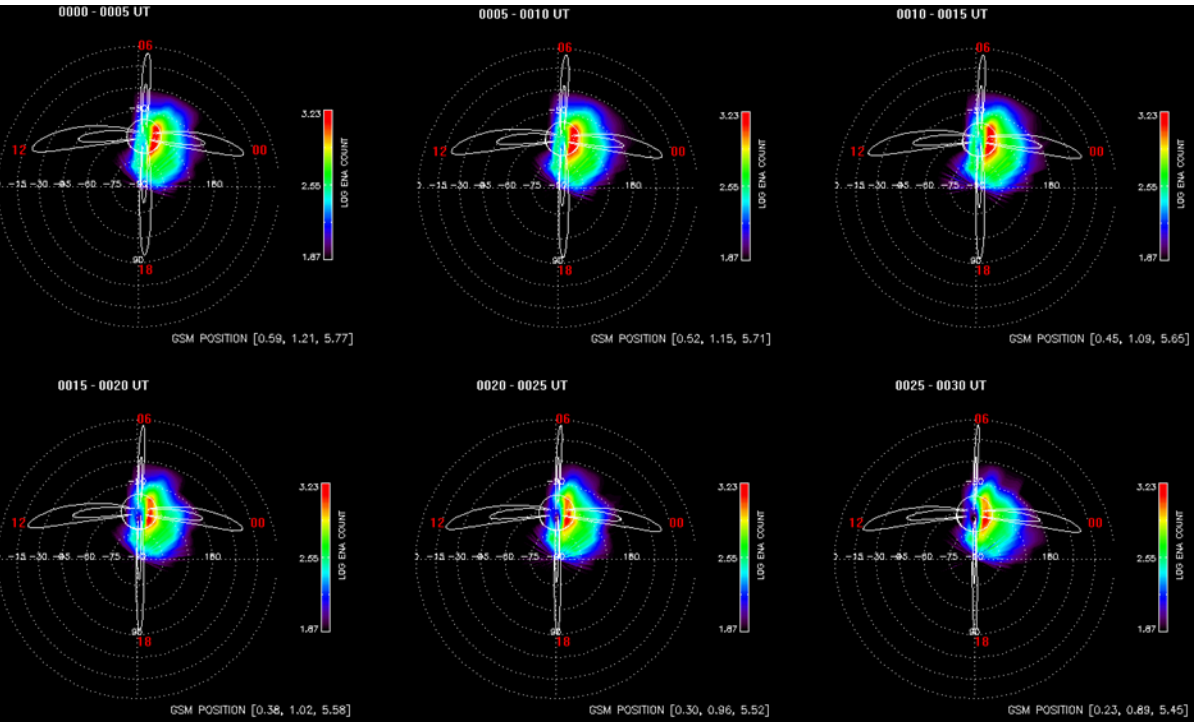
Figure 15. Fig. 15. Recovered ENA images from retrieved ion-fluxes using five-minute integration measurements displayed in the same format em- ployed in the left panel of Fig. 1. The epochs are provided at the top of each